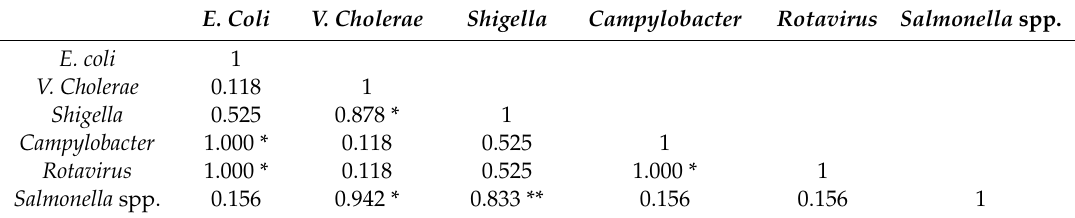
Table 6. Pearson correlation between